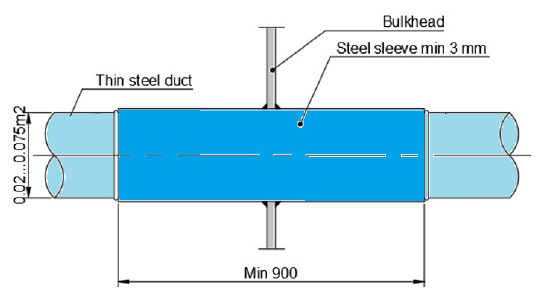
Figure 7. A class fire division—penetration of thin plate ventilation duct, area 0.02–0.075 m 2 .